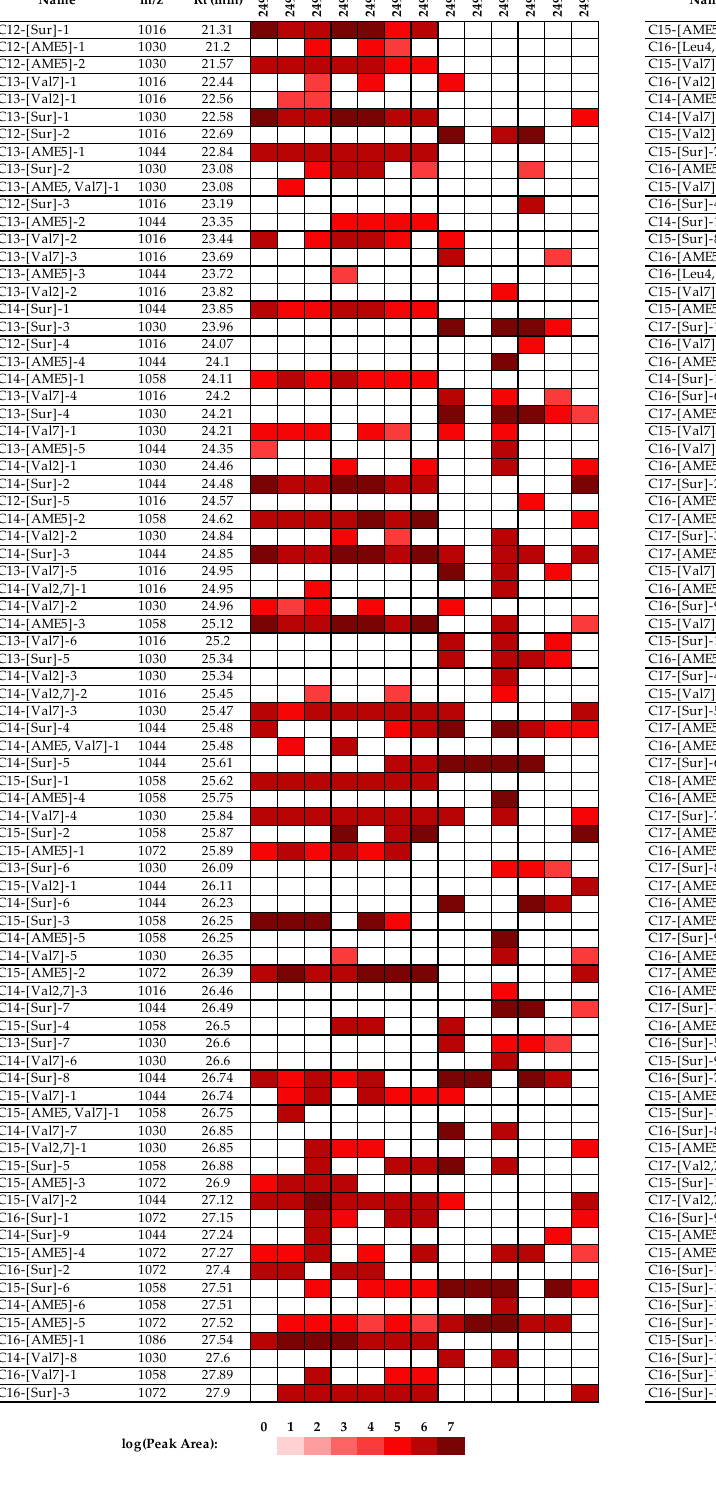
Figure 4. Relative amounts of the detected surfactin molecules of B. atrophaeus (SZMC 24978), B. cereus (SZMC 24994), B. pumilus (SZMC 24987), B. subtilis (SZMC 24992, SZMC 24999), and B. velezensis (SZMC 24980, SZMC 24981, SZMC 24982, SZMC 24983, SZMC 24984, SZMC 24985, SZMC 24986, SZMC 24995)